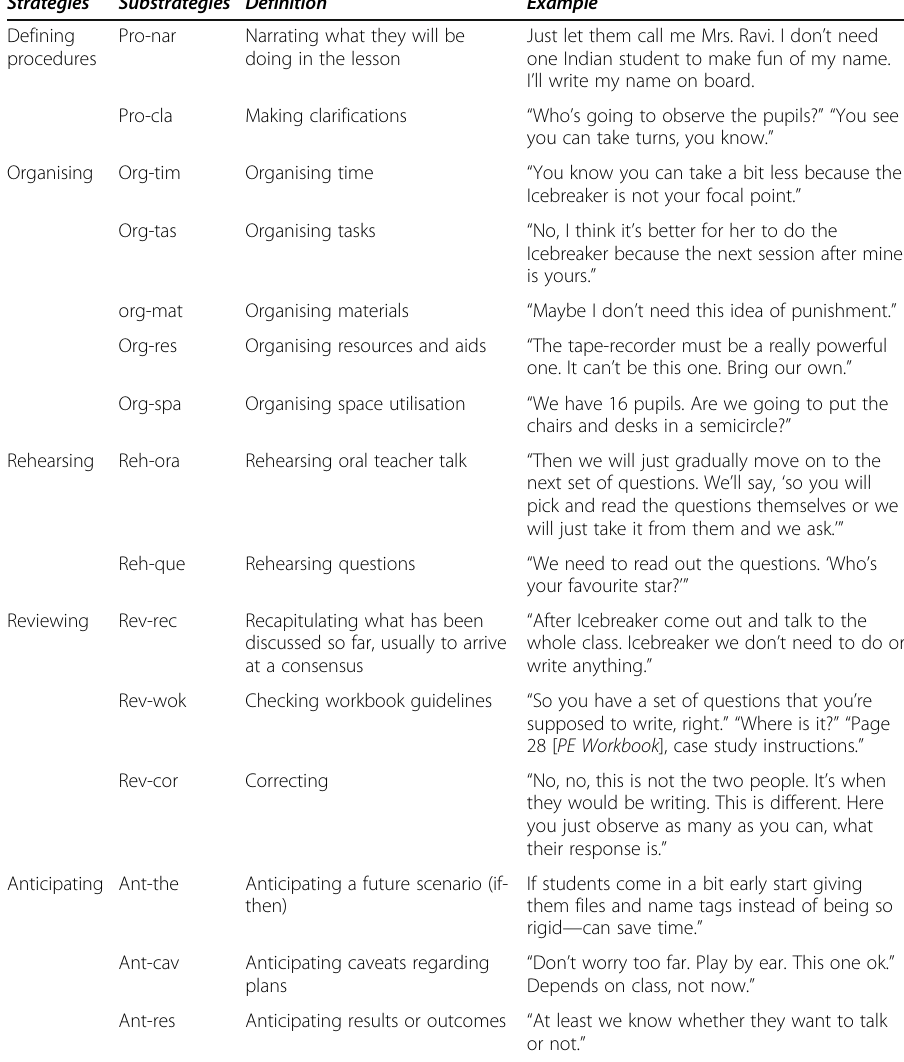
Table 1 Strategies, substrategies, their definitions, and typical cases of strategy use by student teachers in dialogic lesson-planning discussion